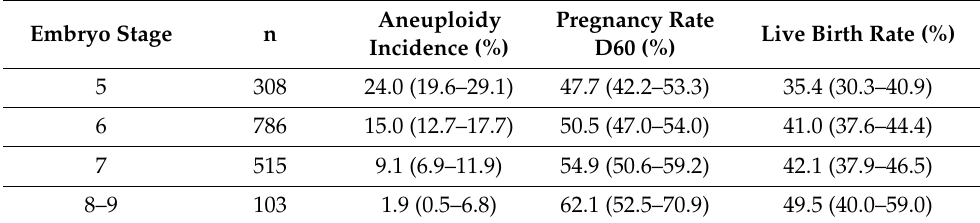
Table 4. Aneuploidy incidence, pregnancy, and live birth rates among embryos of different develop- ment stages. All three parameters were significantly affected by the embryo’s development stage ( p < 0.001). Only one stage 4 embryo was present in the database and it was therefore excluded from this analysis. Data are presented as mean with 95% CI. Aneuploidy Pregnancy Rate Embryo Stage n Incidence (%) D60